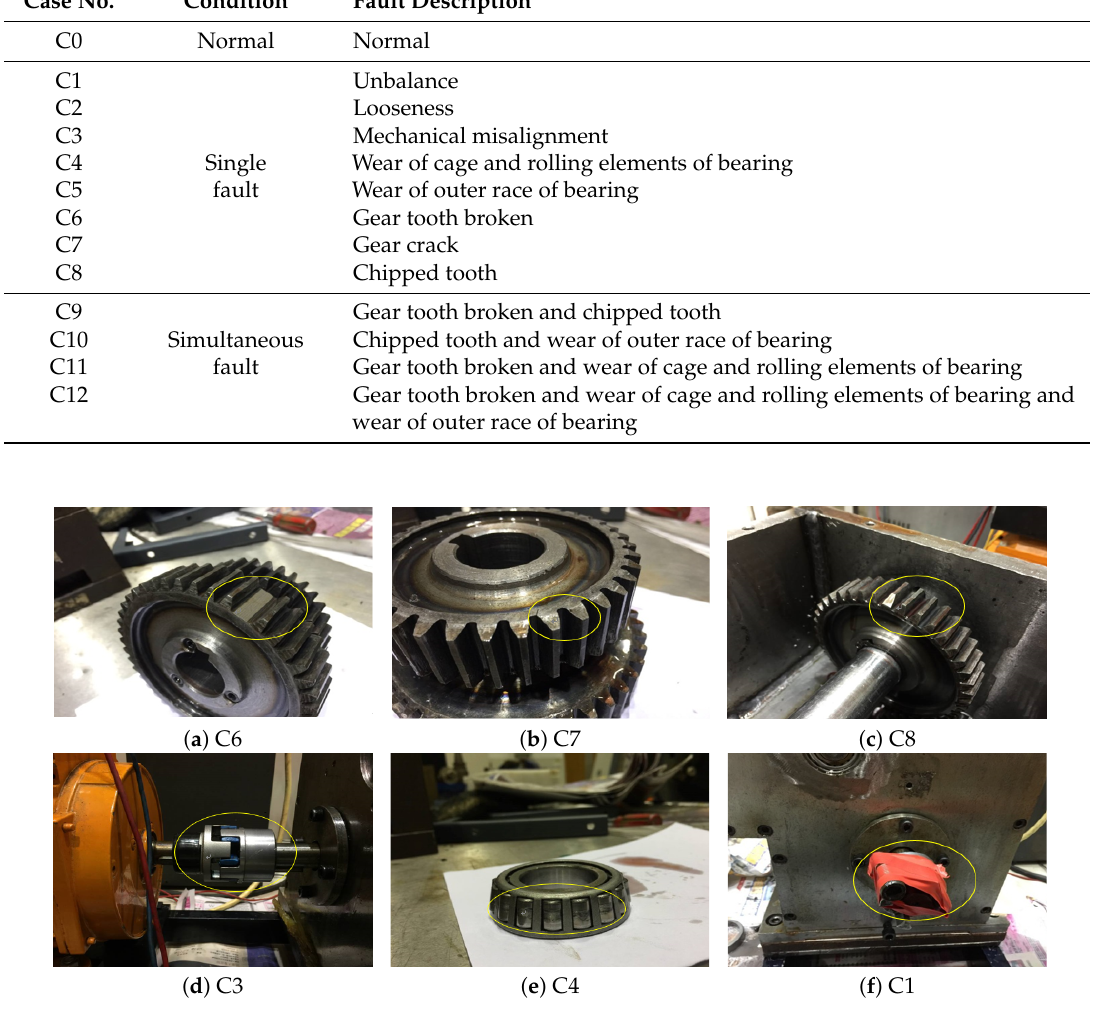
Figure 5. Singular Component Failure in WTGS. ( a ) Gear tooth broken fault; ( b ) gear crack fault; ( c ) chipped tooth fault; ( d ) mechanical misalignment fault; ( e ) wear of cage and rolling elements of bearing; ( f )